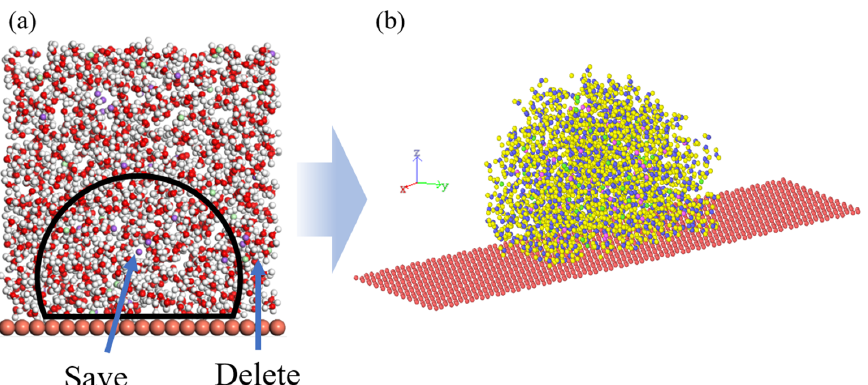
Figure 1. Simulation system of physiological saline. ( a ) The area to be extracted from the initial model, ( b ) the final model for simulation.